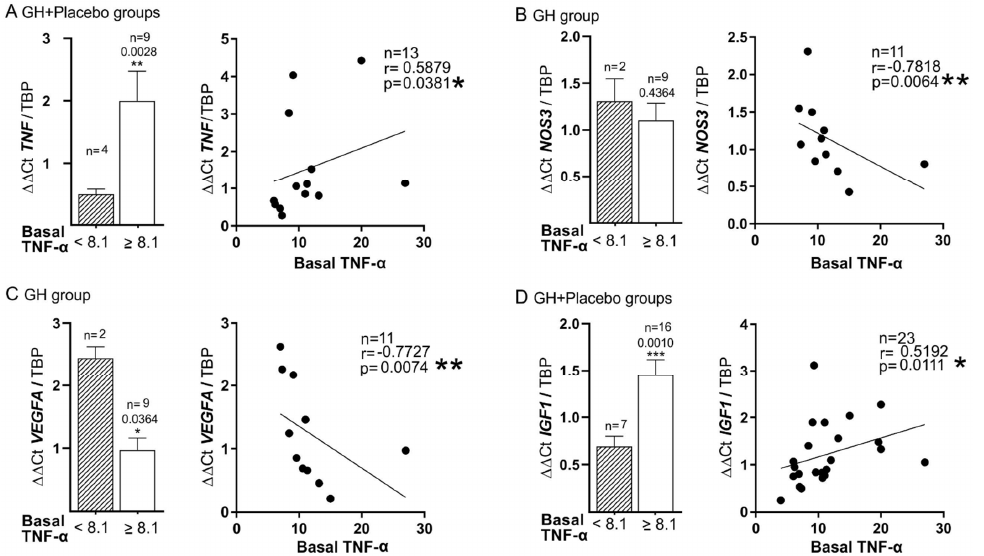
Figure 3. Baseline plasma levels of TNF- α related to different muscle gene expressions in DM patients. Both groups: GH and placebo. Correlation between plasma TNF- α and muscle TNF ( A ), NOS3 ( B ), VEGFA ( C ), and IGF-1 ( D ) mRNA expressions. TBP: housekeeping gene used as an expression control gene. * p < 0.05; and ** p < 0.001.